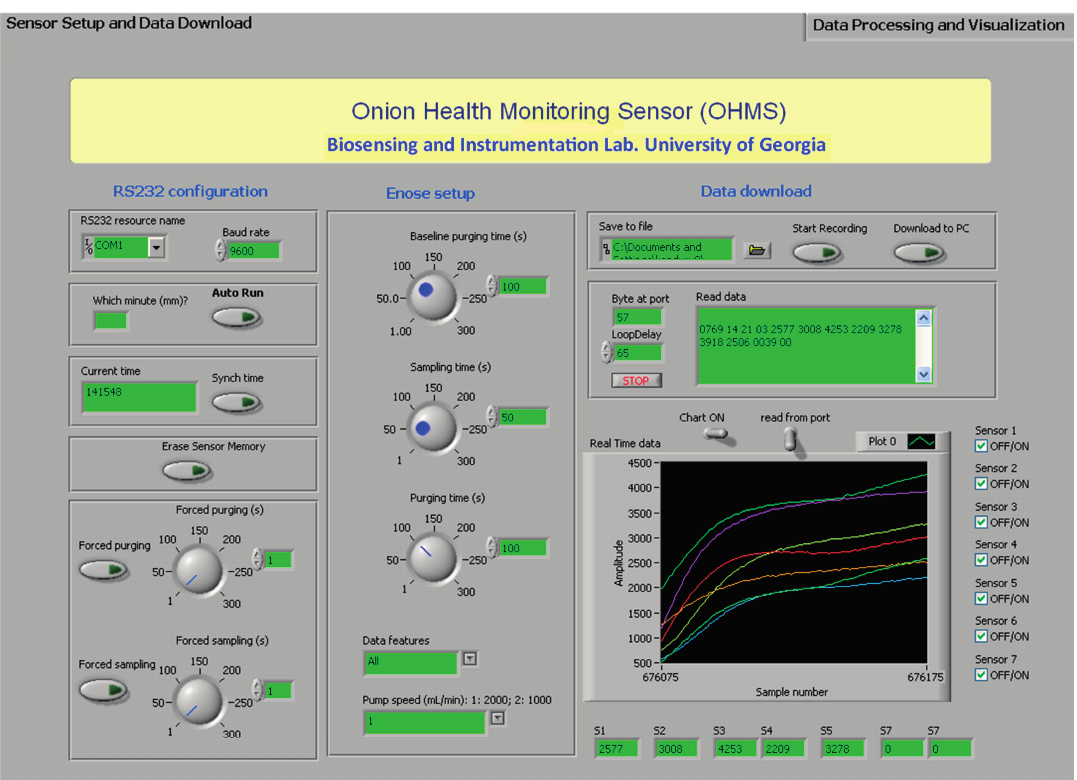
Figure 8. “Sensor setup and data download” tab of the GUI software. Primary functions include: Recording each MOS sensor response, displaying the response, downloading the saved data in the device to the PC, erasing the device memory, synching time, and forced